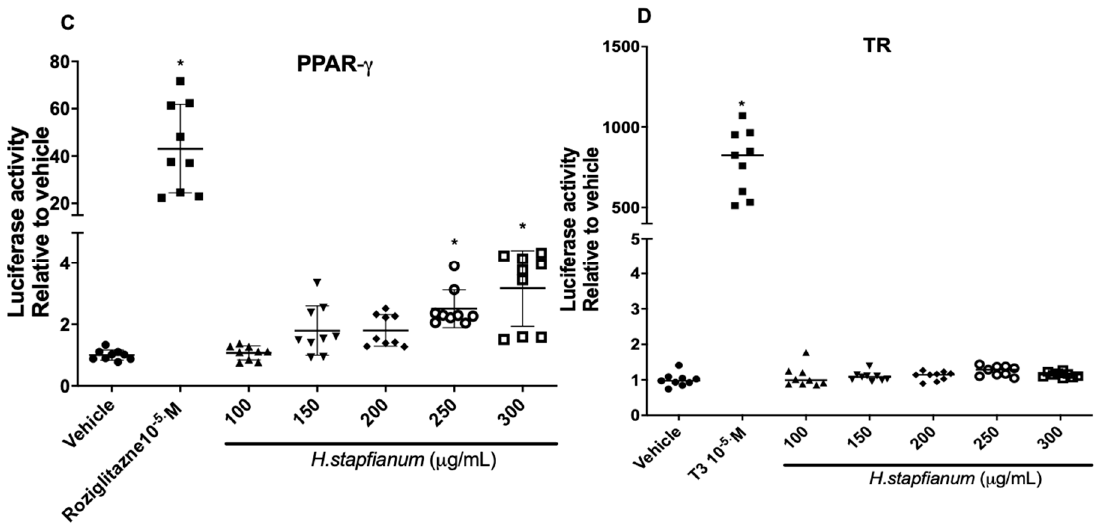
Figure 2. HeLa cells’ viability under treatment with ethanol extract of H. stapfianum Ravena (Amaryllidaceae) leaves (EE), and the action of the same EE on nuclear receptors PPAR \ α and PPAR- γ . ( A ) HeLa cells were treated with different concentrations of EE (200–1000 µg/mL) for 24 h. Cell viability was measured with MTT assay and appropriate concentration under 300 µg/mL (red arrow) ( B ) Increasing concentrations of EE (100–300 µg/mL), vehicle (DMSO 0.1% v / v ), or positive control (bezafibrate 100 µM) on PPAR- α transcriptional activity in HeLa cells, measured with luciferase gene reporter assay. ( C ) Increasing concentrations of EE (100–300 µg/mL), vehicle (DMSO 0.1% v / v ), or positive control (rosiglitazone 10 µM) on PPAR- γ transcriptional activity in HeLa cells, measured with luciferase gene reporter assay. ( D ) Increasing concentrations of EE (100–300 µg/mL), vehicle (DMSO 0.1% v / v ), or positive control PC (thyroid hormone T3 10 µM) on TR- β transcriptional activity in HeLa cells, measured with luciferase gene reporter assay. MTT data are means + SD of three independent experiments expressed as a percentage compared to solvent control (DMSO, 0.1% v / v ). For gene reporter assay, data are reported as median + SD of three independent experiments, and the results were analyzed by Kruskal–Wallis and Dunn’s post hoc test. * represent p > 0.05.